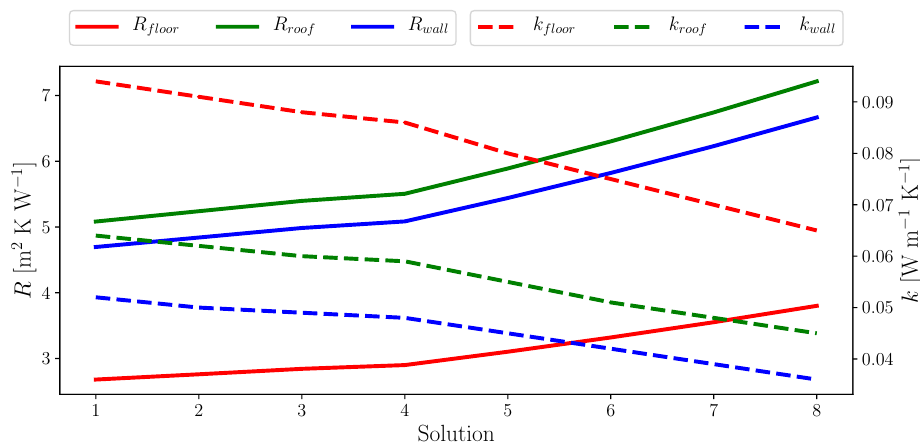
Figure 8. Pareto path of optimization process for building envelop thermal resistances and conduc- tivities using 2D